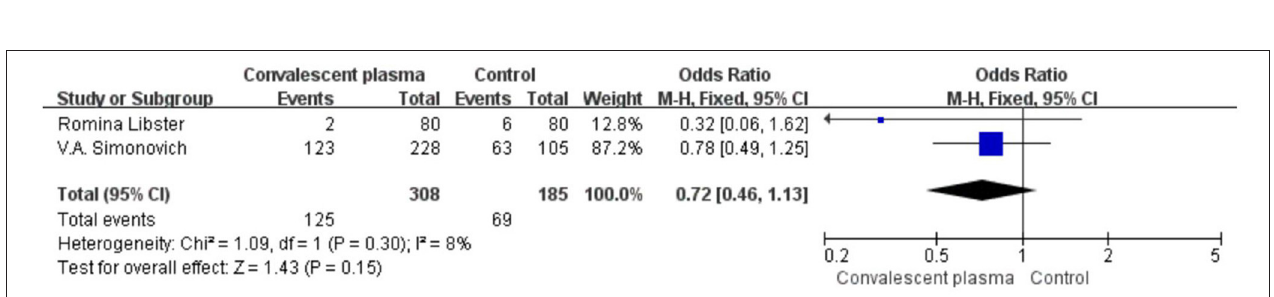
FIGURE 8 | Forest plot of mean difference (MD) of the MV stay among patients treated with convalescent blood products and controls ( n = 2 studies). Weights are from fixed-effects analysis. CI, confidence interval; MV, mechanic ventilation.